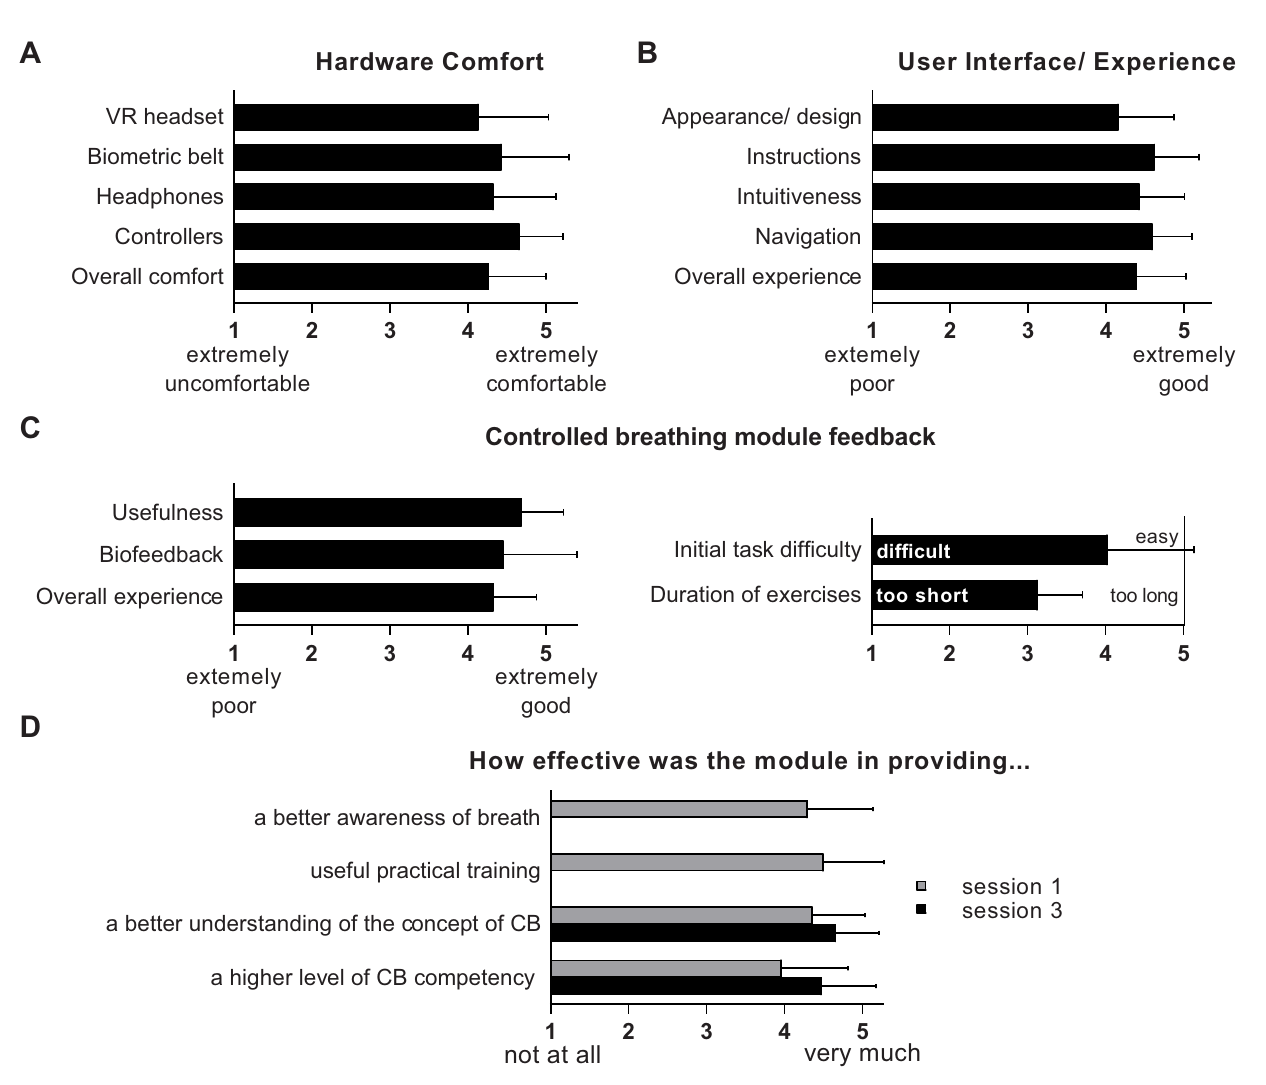
Fig 3. User survey feedback on Performance Edge. Participants provided feedback before and after using Module 2 –Controlled Breathing, across 3 training sessions. Survey responses were collected for the entire Performance Edge VR platform after session 1, relating to A) hardware comfort and B) software components and user interface / experience. Specific to Module 2, users provided feedback on C) perceived utility, biofeedback and overall experience, as well as task difficulty and appropriateness of durations. D) Users also provided feedback on perceived effectiveness of training on aspects of breathing awareness, usefulness, understanding and competency after session 1 (and after session 3, where indicated). Data presented as weighted averages based on a 5-point Likert scale (n = 30); mean ±